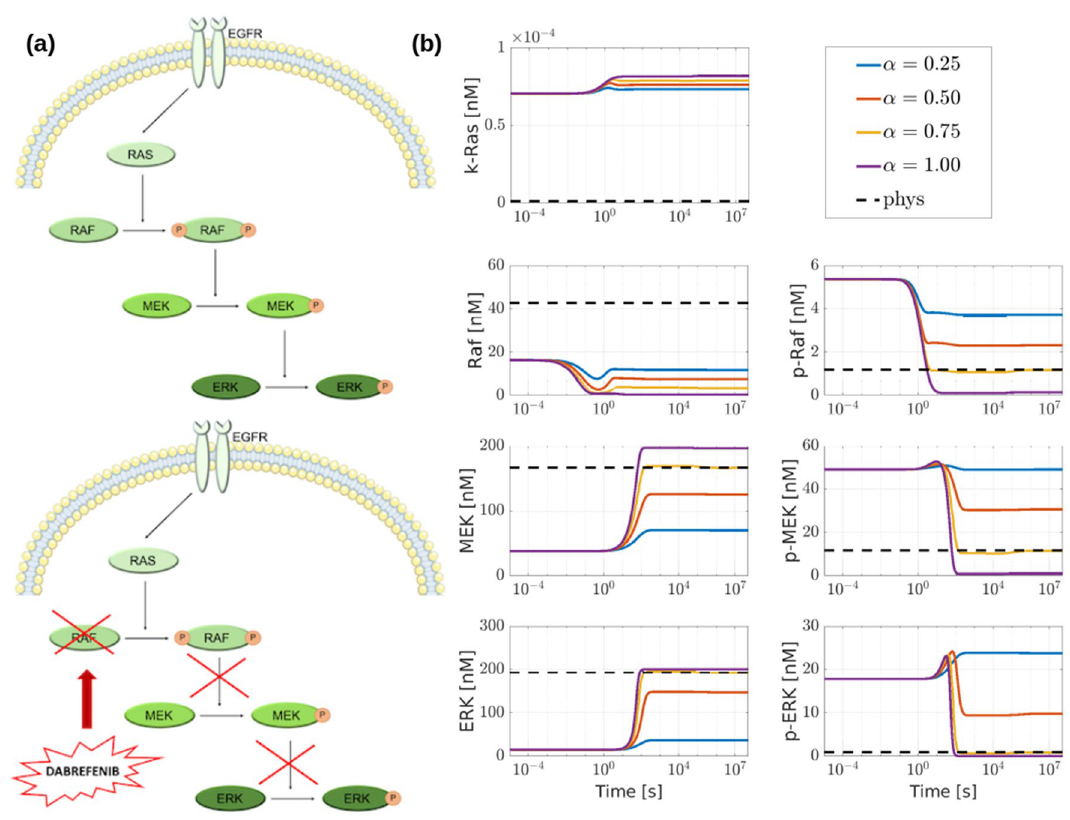
Figure 5. Effects of the drug on the Ras–Raf–MEK–ERK cascade (MAPK pathway). ( a ) Schematic representation of the MAPK pathway extracted from the CRC–CRN and of the changes induced by the drug Dabrafenib modeled as a competitive inhibitor of Raf kinase. ( b ) Time-courses of the concentrations of the proteins within the MAPK cascade obtained by solving the system of ODEs associated to the modified CRC– CRN with the initial state set equal to the equilibrium of the network affected by a GoF mutation of KRAS. Different lines correspond to a different value of the initial concentration of the drug; the black dotted line depicts the value of the protein concentrations in the physiological cell that is taken as reference.